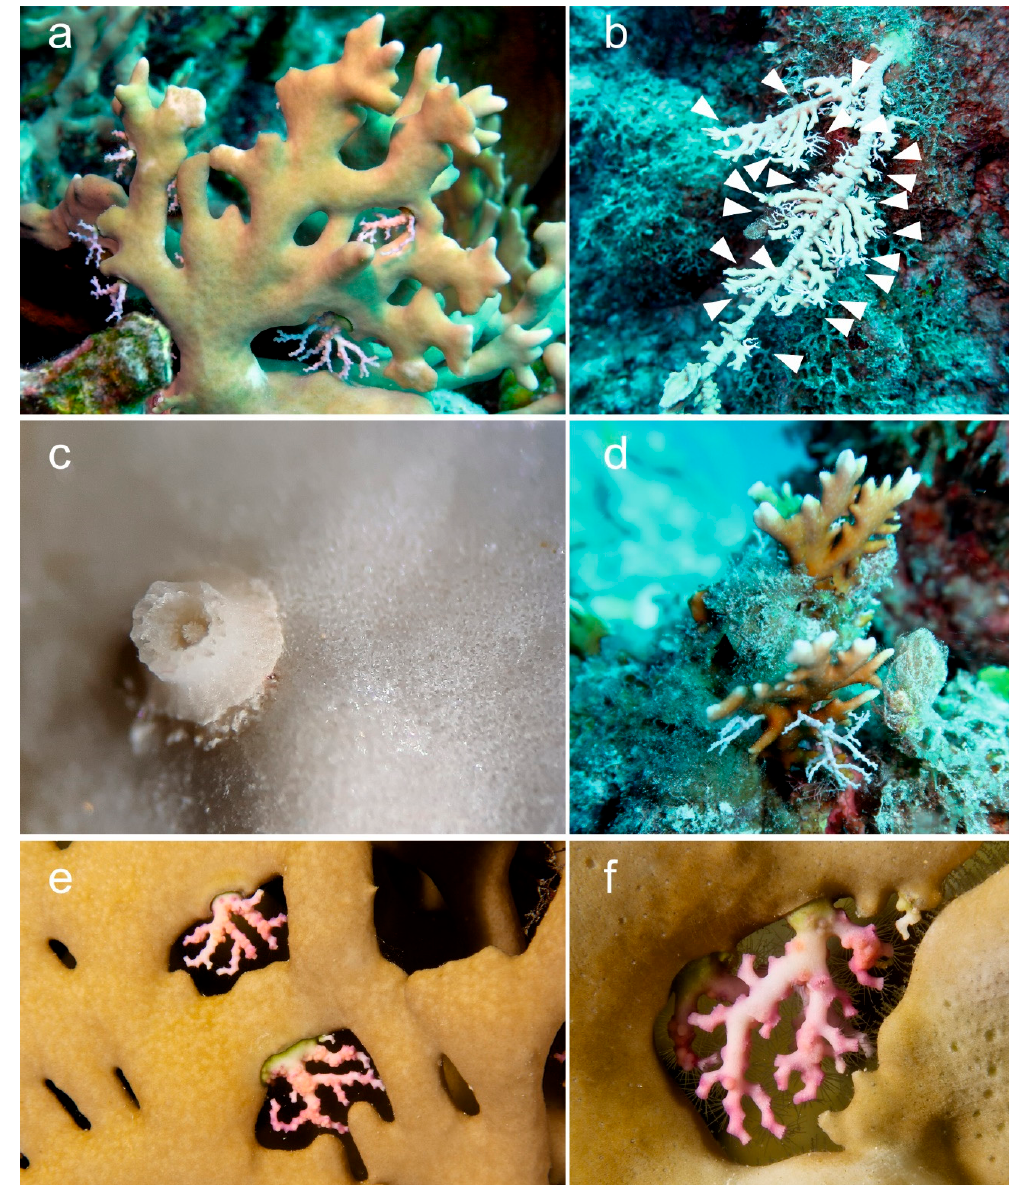
Figure 2. Stylaster - Millepora association. ( a ) Overview of field appearance; ( b ) high number of S. roseus colonies growing on a M. alcicornis colony; ( c ) a single S. roseus recruit on M. alcicornis ; ( d ) exposure of S. roseus when overgrowing a fire coral colony; ( e , f ) peculiar pattern of S. roseus and M. alcicornis growth and close-up of both colonies with extended polyps.